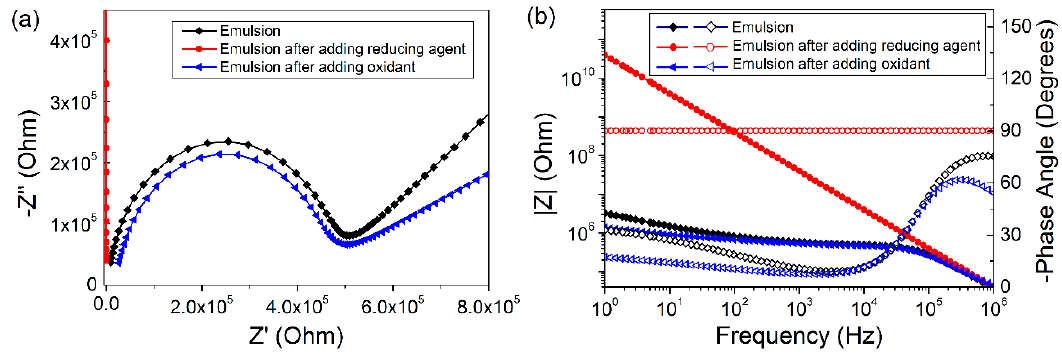
Figure 8. ( a ) Nyquist and ( b ) Bode diagrams before and after the redox regulation of the Pickering emulsion. The solid symbols are the impedance modulus-frequency curve and the hollow symbols are the phase angle-frequency curve in the Bode diagram ( b ).